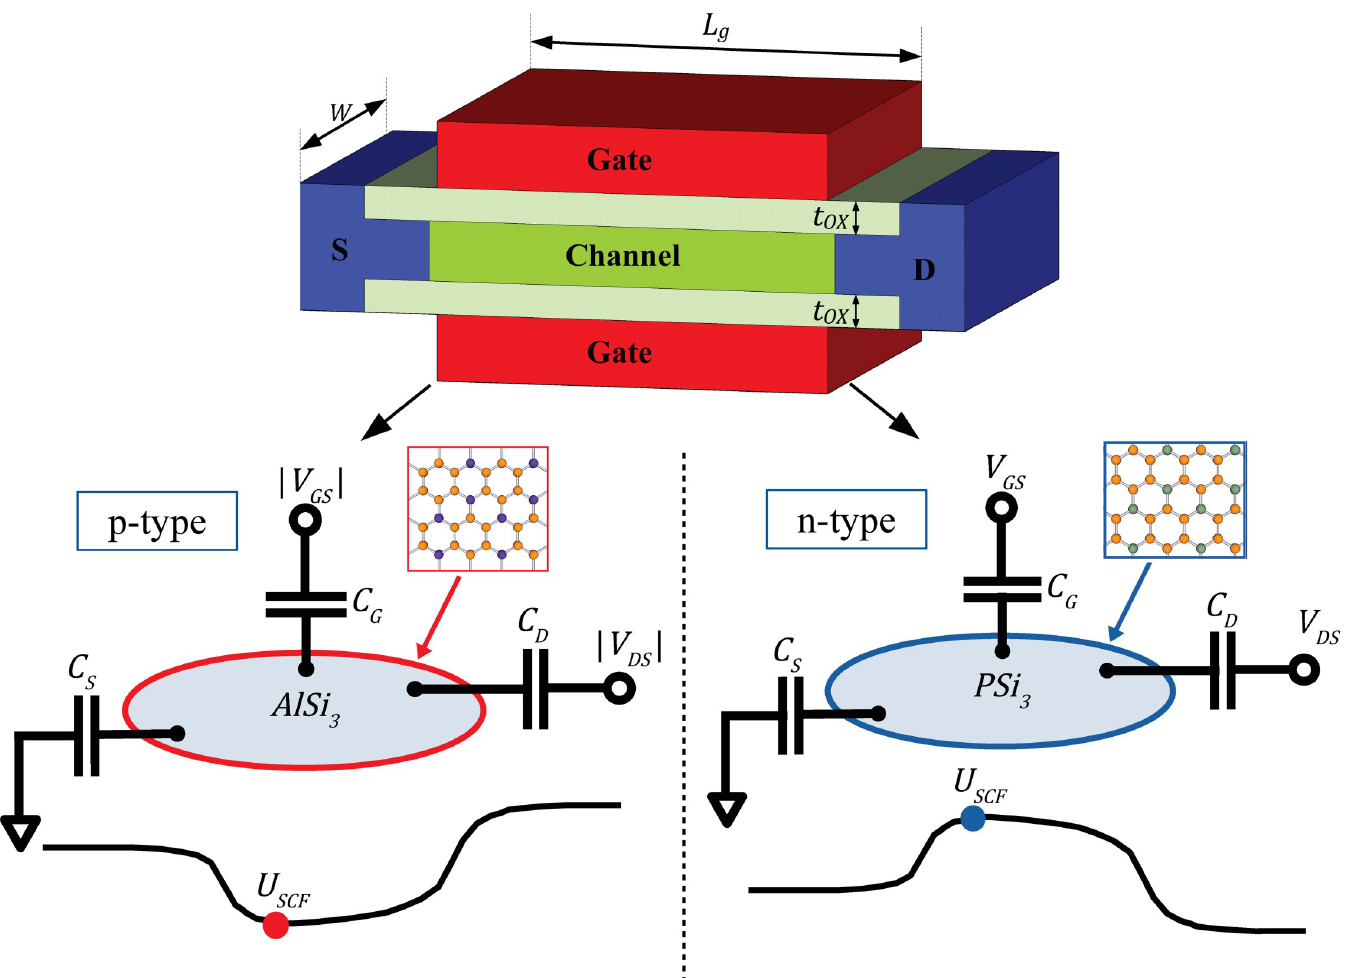
Fig 1. Schematic structure and circuit diagrams of n-type and p-type uniformly doped silicene FETs. Brown atoms represent silicon (Si) atoms; purple atoms represent aluminium (Al) atoms; and grey atoms represent phosphorus (P) atoms.